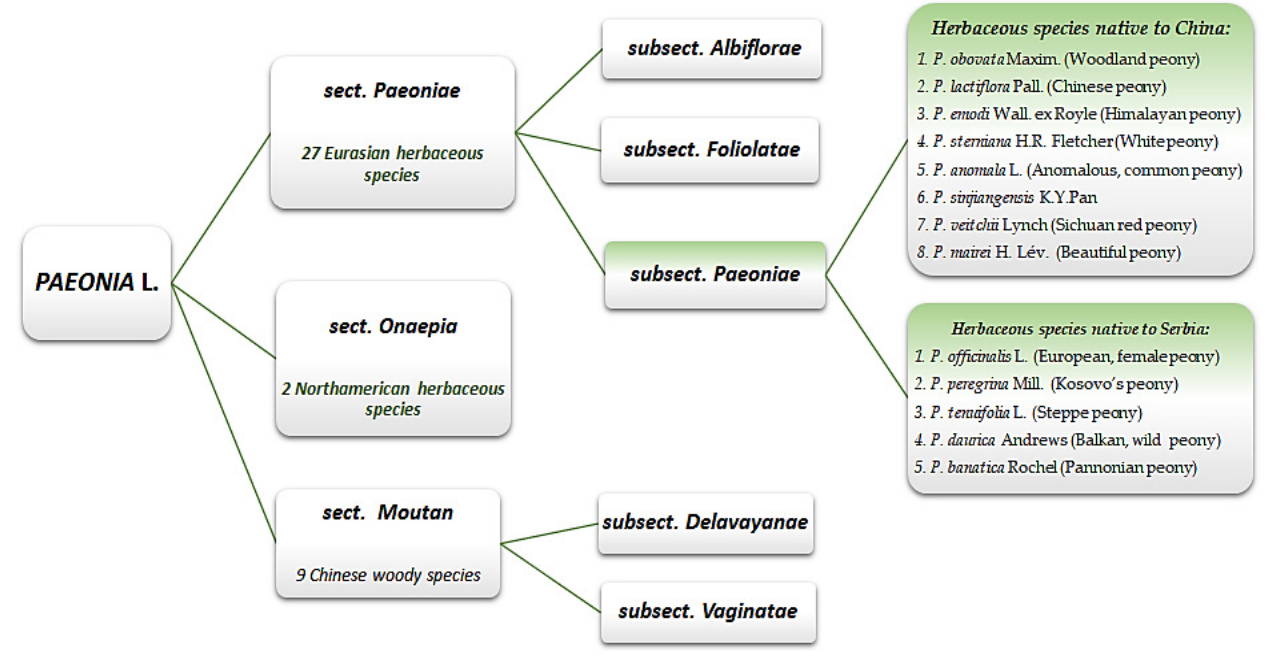
Figure 1. Division of genus Paeonia , with focus on herbaceous species native to Serbia and China.